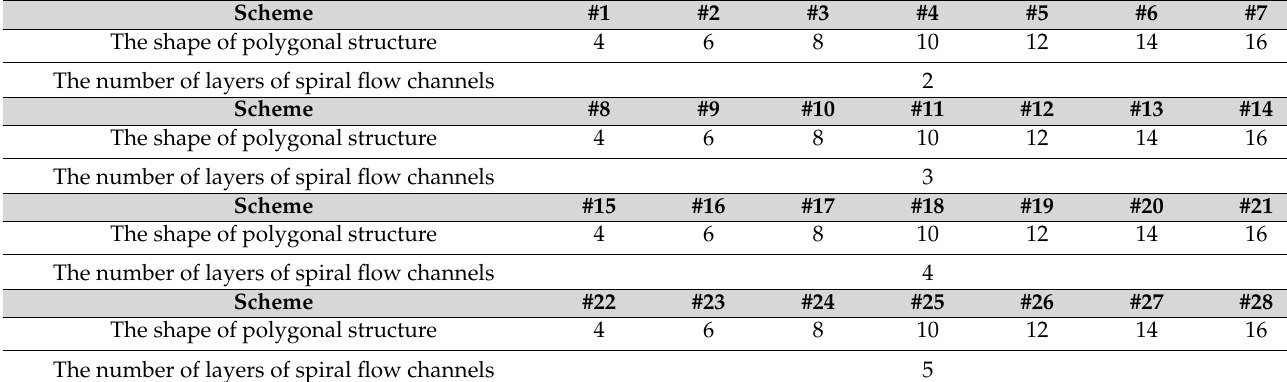
Table 1. Schemes with different polygonal structures and number of layers.